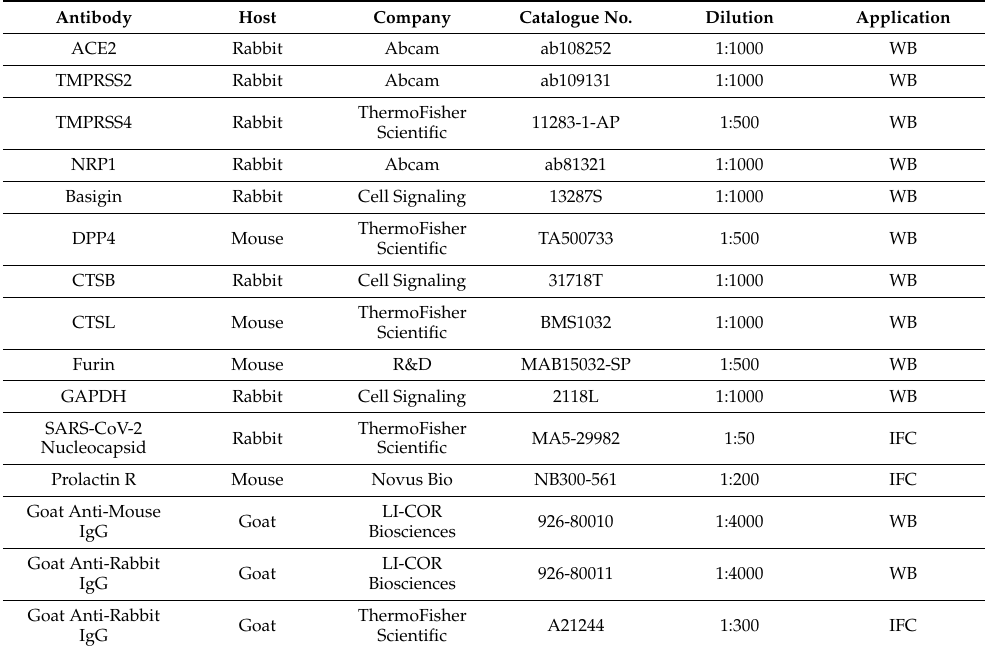
Table 2. The antibodies used in this